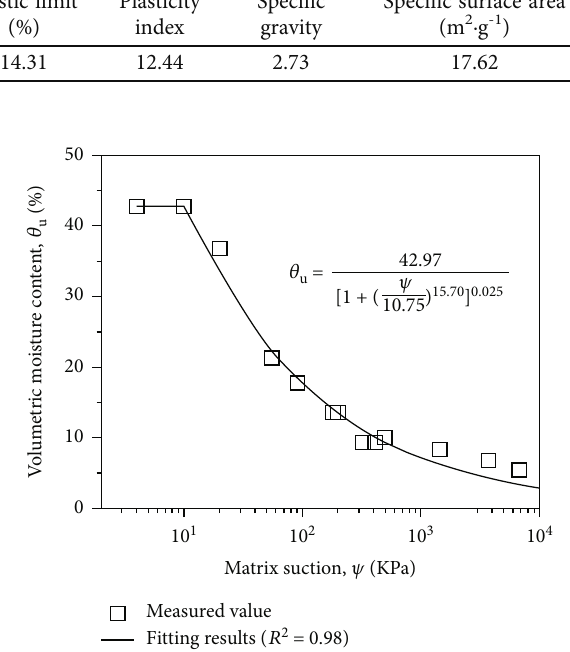
Figure 3: The soil-water characteristic curve (SWCC) of the Qinghai silty